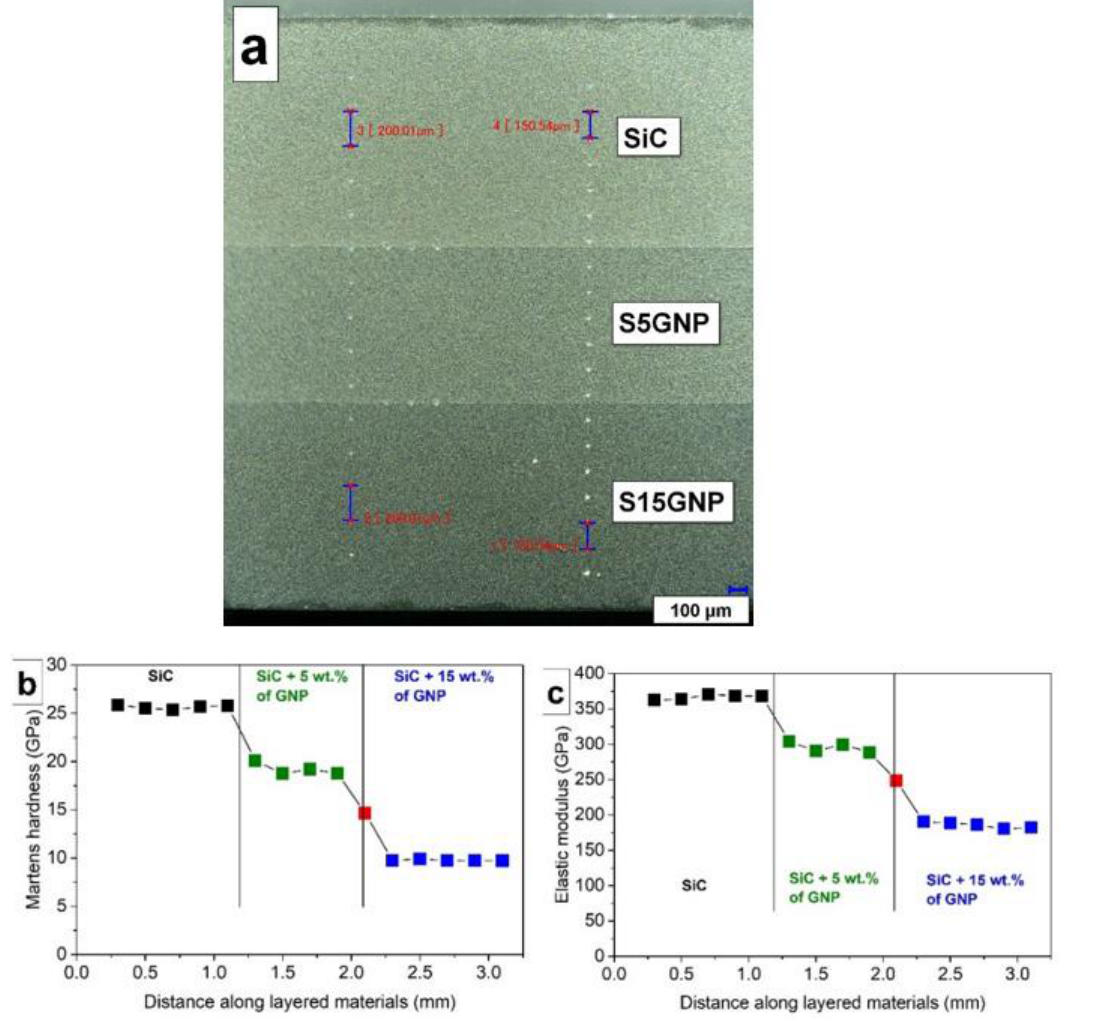
Figure 4. Optical micrograph of the cross-section of 3-layered composites–C3-50 ( a ), instrumented hardness ( b ), and indentation elastic moduli ( c ) of the layered composites measured on the cross-section.